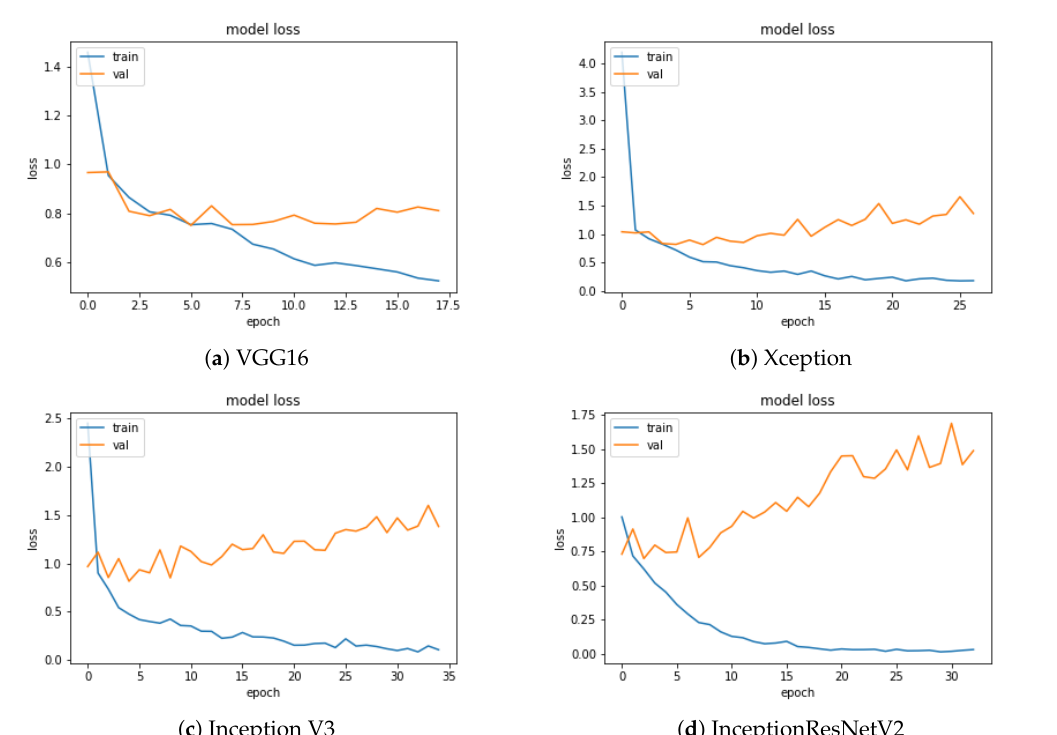
Figure 5. Loss function evolution for each network as a function of the epochs.